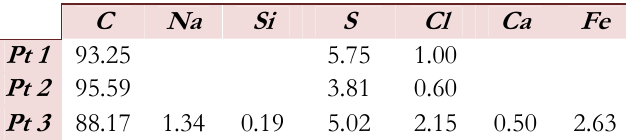
Table 3: EDS analysis (weight%) of areas shown in the Fig. 20.